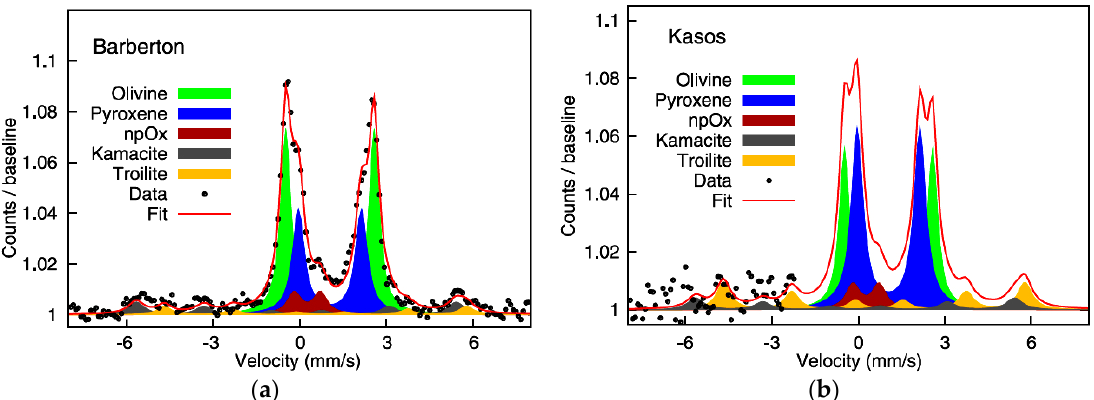
Figure 51. Mössbauer spectra of cobbles from the Barberton group: Barberton ( a ) and Kasos ( b ), measured by Opportunity rover at the Meridiani Planum, Mars. NpOx means nanophase ferric oxide. Adapted from [148].